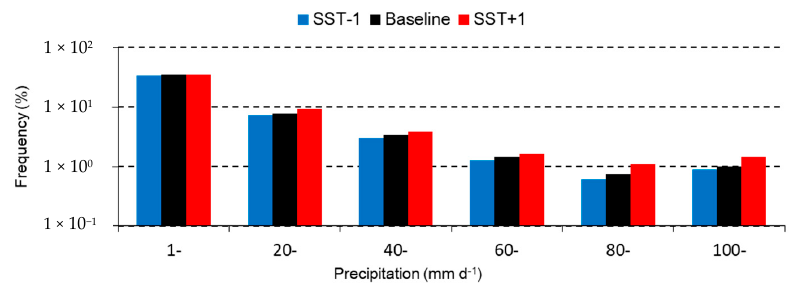
Figure 9. Frequency distribution of daily precipitation at the meteorological observatories in August 2014 in SST − 1, the baseline, and SST+1 cases.